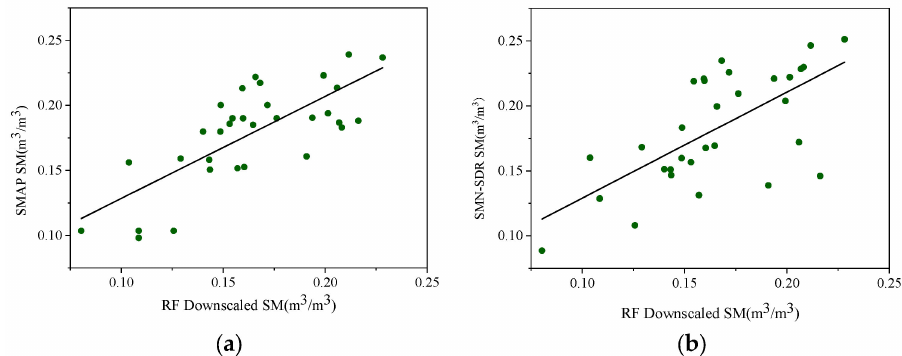
Figure 10. Scatter plot of SM from SMD-RF downscaling versus original SMAP SM data ( a ) and SMN-SDR in situ measurements ( b